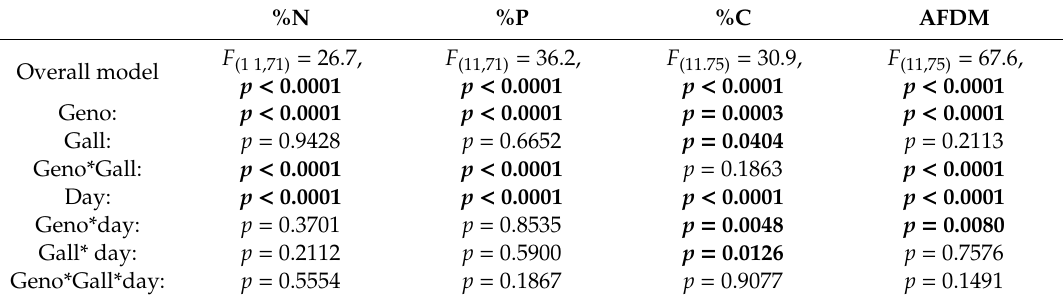
Table 4. Three-way ANOVA results for litter chemistry throughout the decomposition process. Values represent overall F (df1,df2) -ratios and p -values as well as e ff ect test p -values for each main e ff